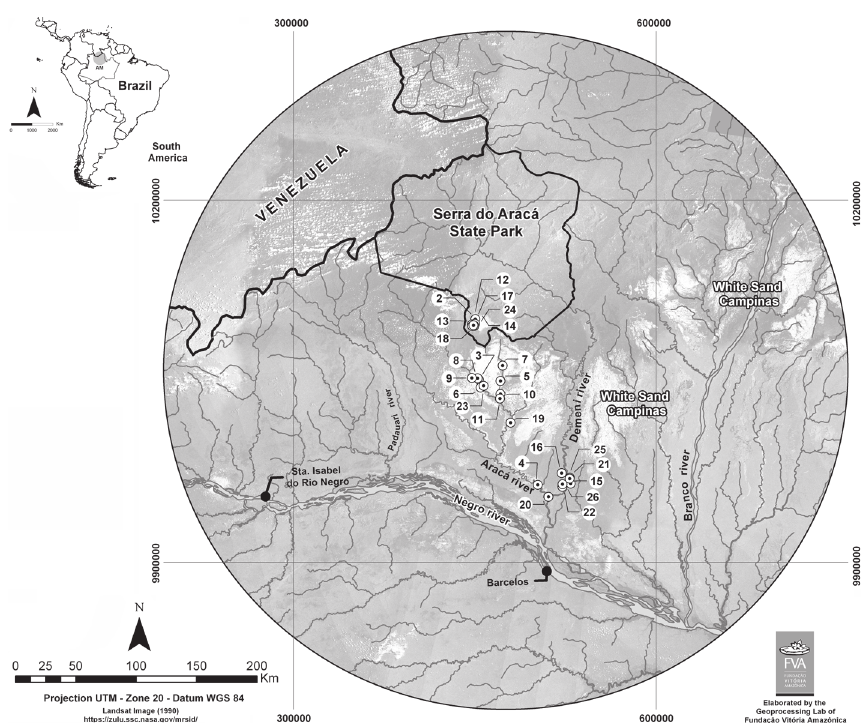
Figure 1. Northwestern region of the state of Amazonas showing the study sites, mainly rivers and municipalities. Note the large areas occupied by white sand campinas in the study region.